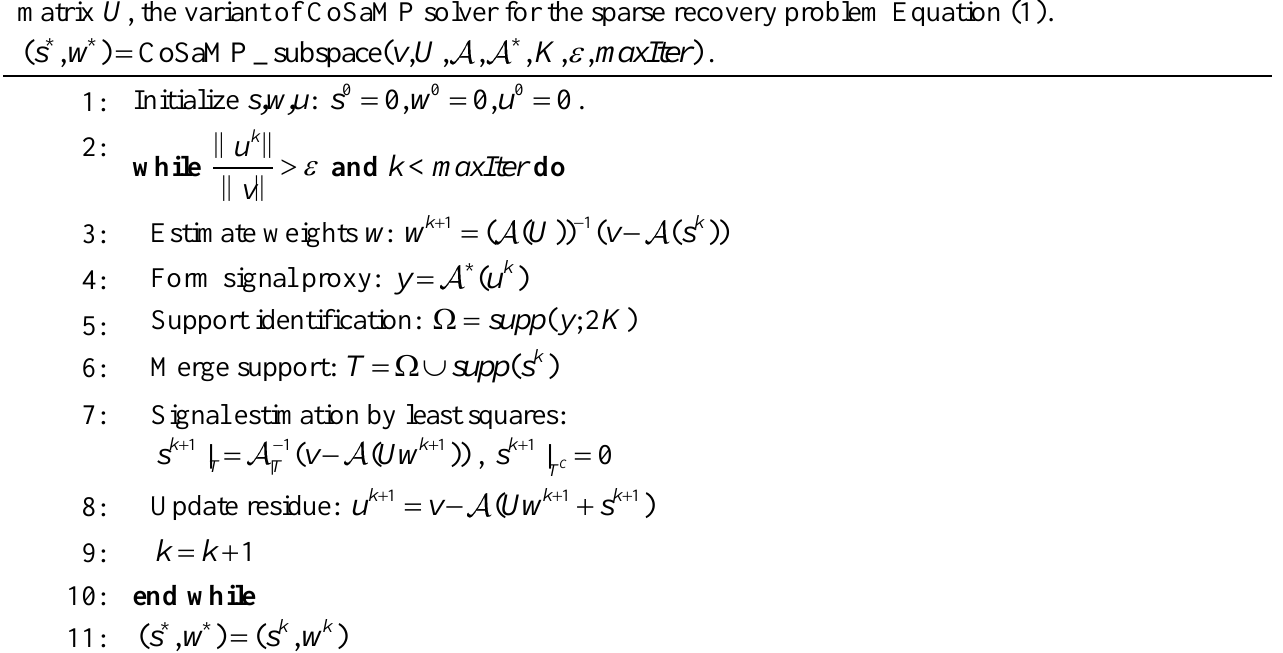
Algorithm 1. Given a fixed subspace spanned by the column space of an n